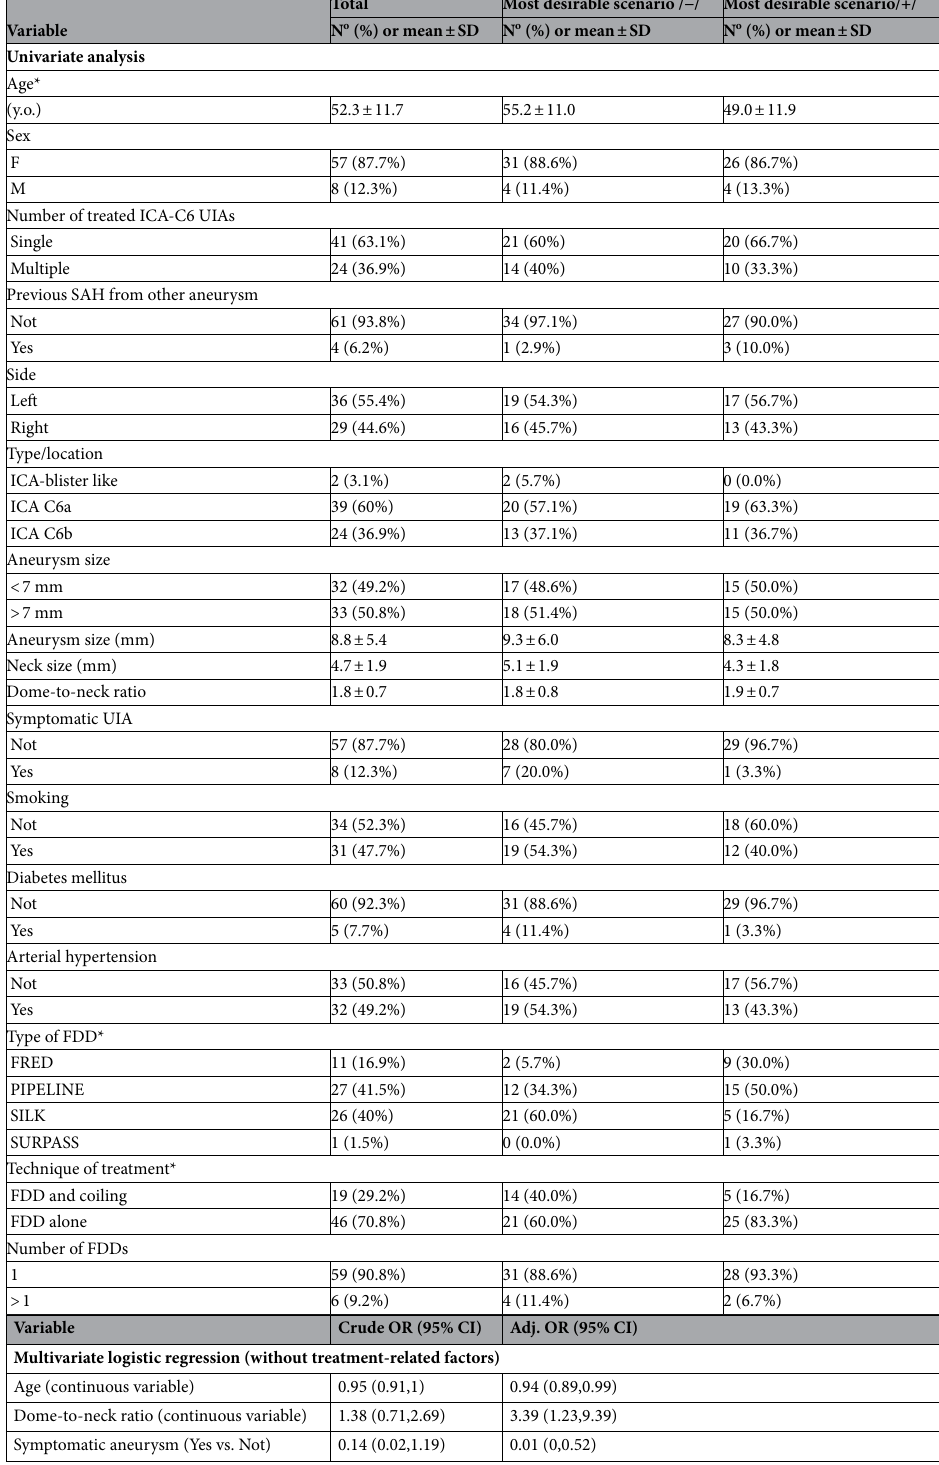
Table 4. Uni- and multivariate analysis of potential predictors of the most desirable scenario (RROC class I at 6 months with uneventful treatment and follow-up course). *Age (continuous variable), OR (95% CI): 0.95 (0.91,1); p = 0.038; Technique of treatment, OR (95% CI): 3.33 (1.03,10.79), p = 0.045; SILK FDD, OR (95% CI): 0.05 (0.01, 0.33), p = 0.002, and p-not significant for the rest of tested